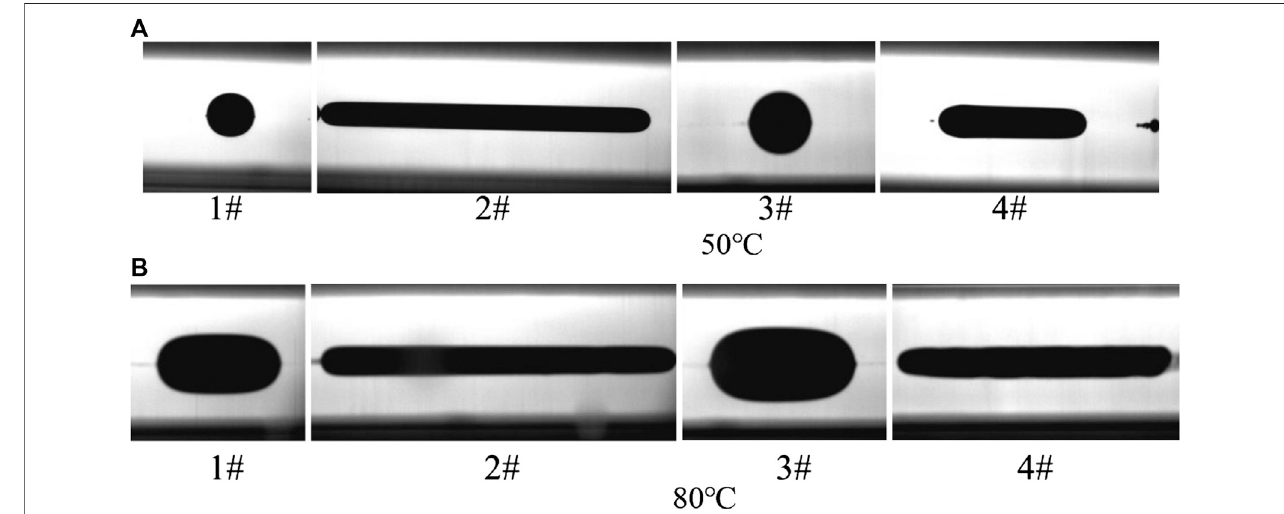
FIGURE 7 | Interfacial tension value of heavy oil under the action of viscosity reducer.